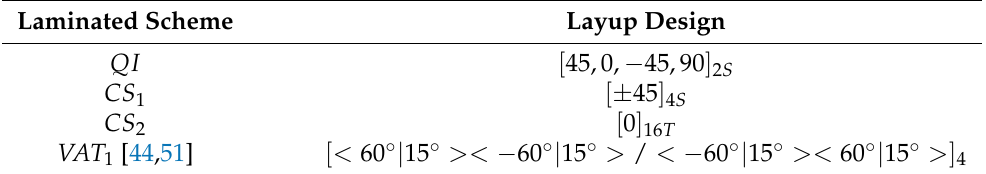
Figure 5. Flowchart of genetic algorithm procedure (MATLAB) in combination with CUF approach (FORTRAN). Table 2. Reference laminate lay-up design and the optimum VAT